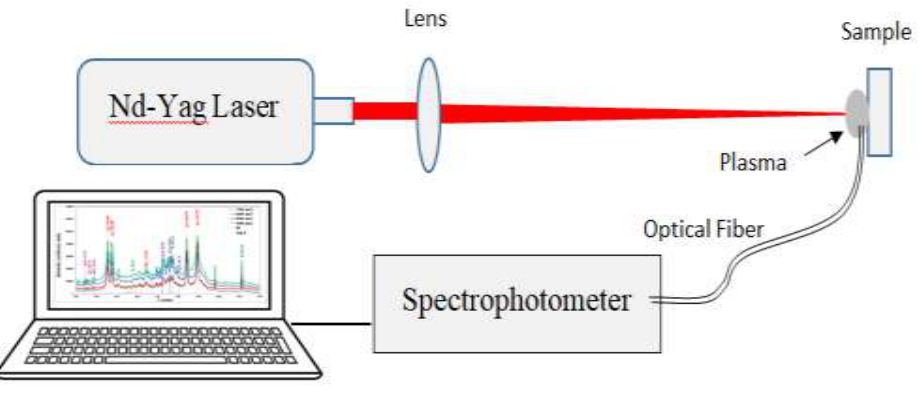
Figure 2: The schematic diagram of the experimental setup of (LIBS).